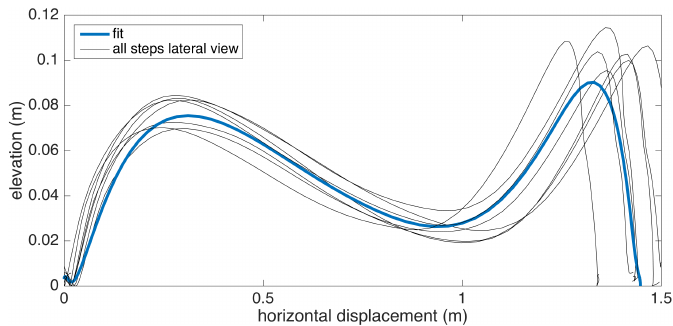
Figure 12. Example average stride profile fit over individual lateral stride